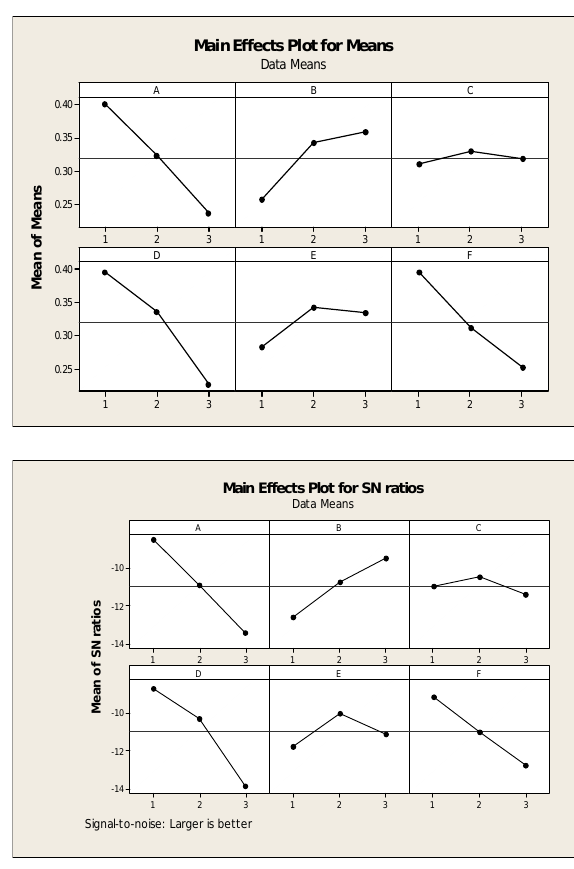
Fig. 4. Signal-to-Noise ratio response graph for surface